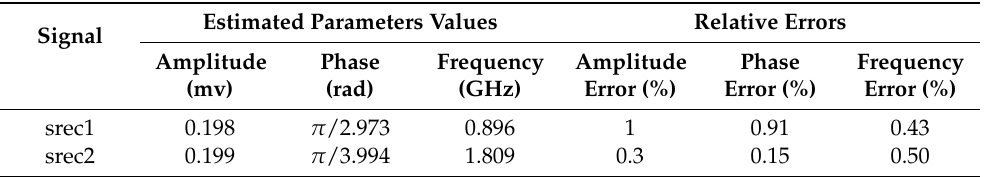
Table 2. Comparison between estimated parameters and the real ones.